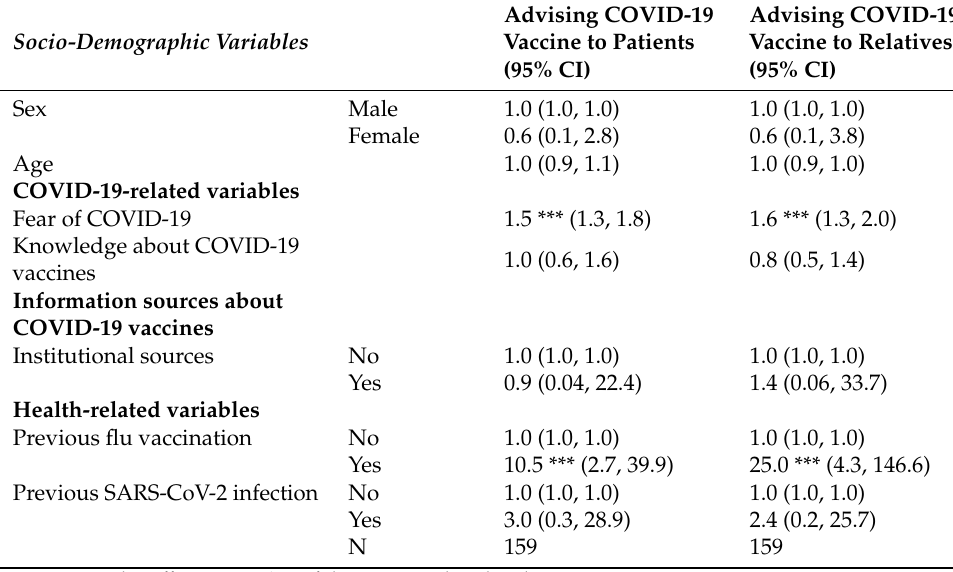
Table 6. Multivariable logistic analysis: